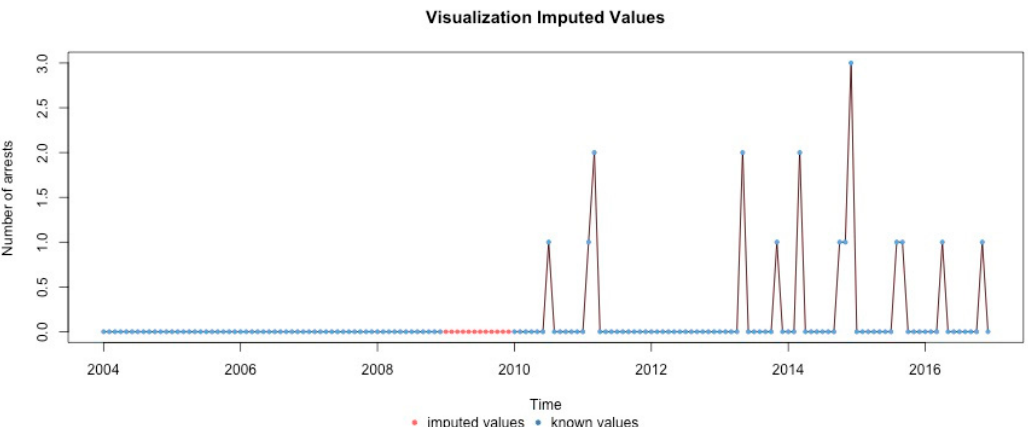
Figure A8. Precursor foreign nationals arrests 2004–2016 in the Czech Republic – imputed missing values.